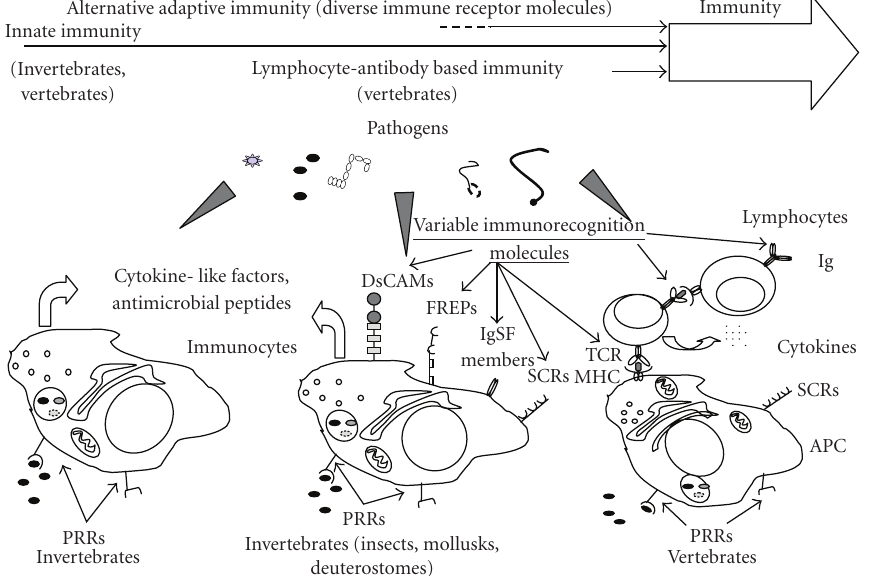
Figure 3: Schematic representation of innate and adaptive immune feature development in animals. All immune cells express nonspecific receptors, for example, pattern recognition receptors that recognize pathogen associated molecular patterns (PAMPs). Several clusters of innate receptors are conserved from plants to humans and are essential components in the defense of self-integrity. Immune cells of inver- tebrates also express various scavenger receptorlike proteins (Croquemort, SCRs) [37, 38, 52, 56, 57], immunglobulin superfamily members (hemolin, DsCAM) [58, 59], and fibrinogen-related peptides (FREPs) [60]; all involved in immune functions (eliminating apoptotic cells, parasites, etc.). Invertebrate immune systems also exhibit receptors with high diversity involved in immune functions: FREPs, SCRs,